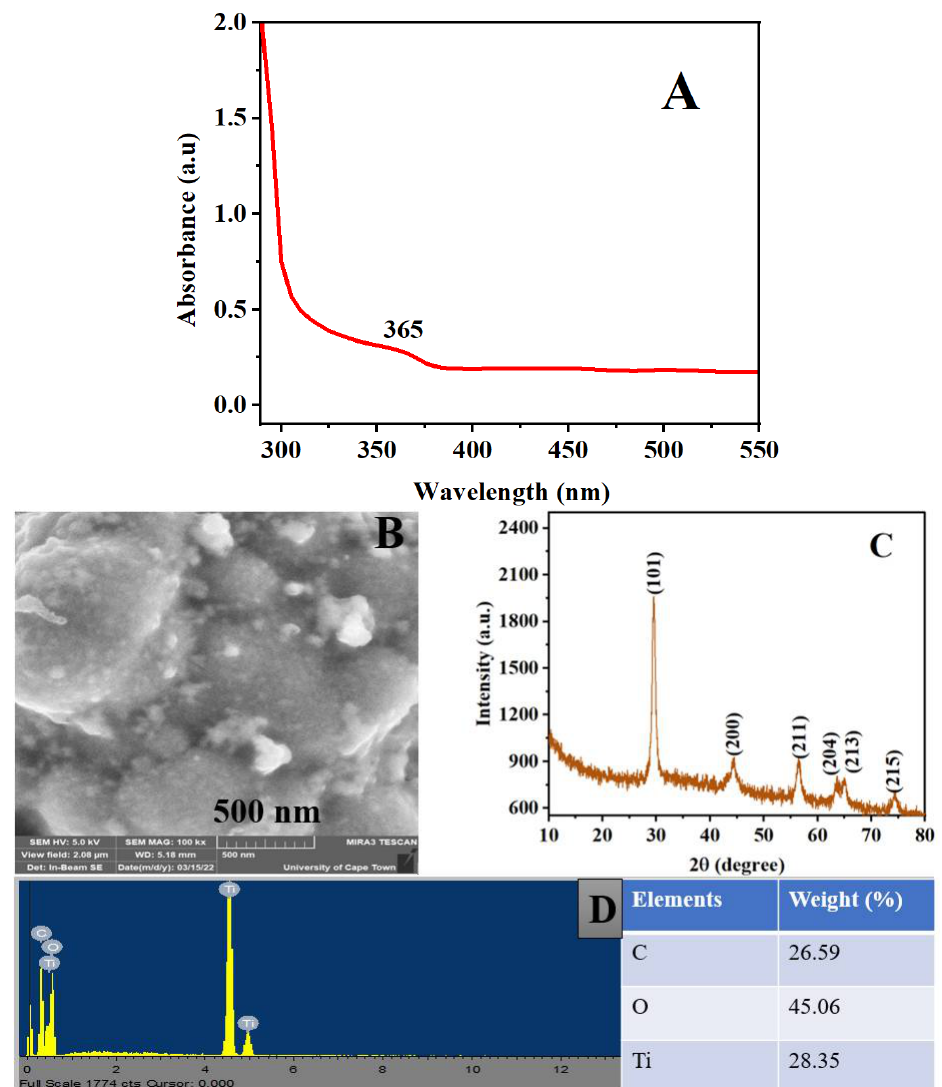
Figure 3. ( A ) UV-VIS spectrum, ( B ) SEM image, ( C ) XRD, and ( D ) EDS of TiO 2